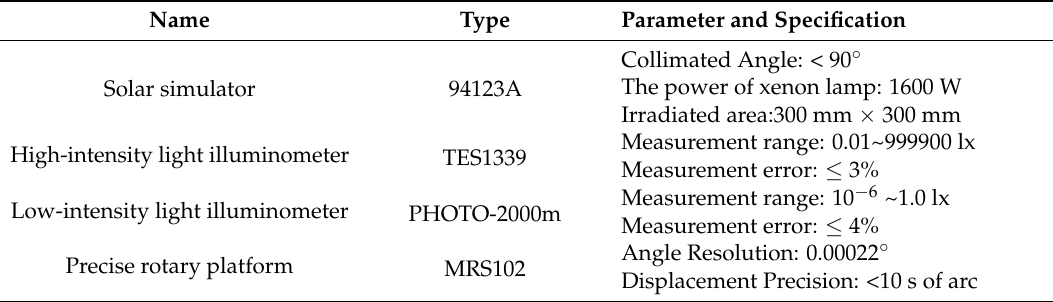
Table 2. Technical data of the measurement devices.